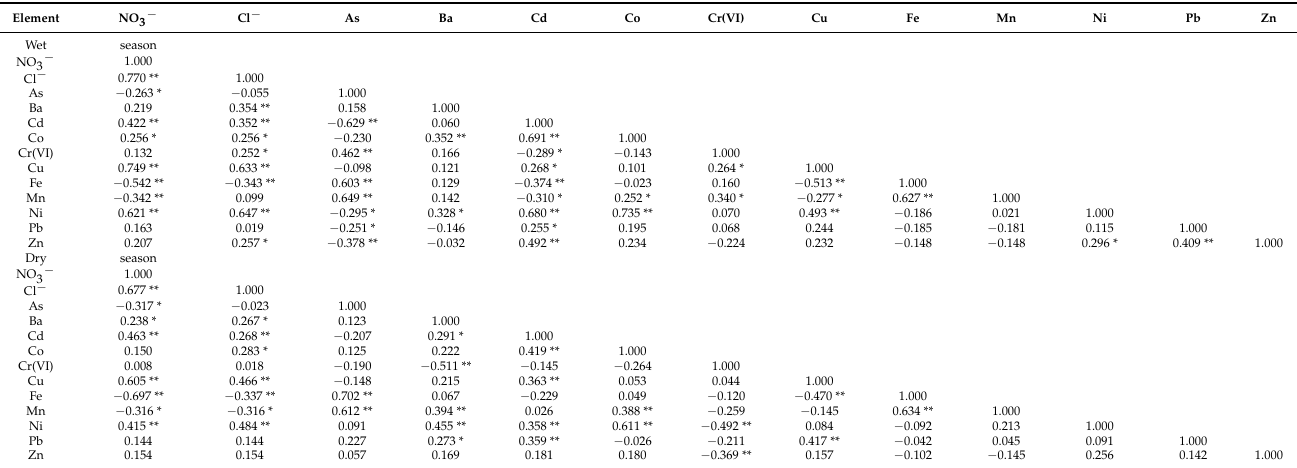
Table 2. Spearman correlation analysis results of pollutants in